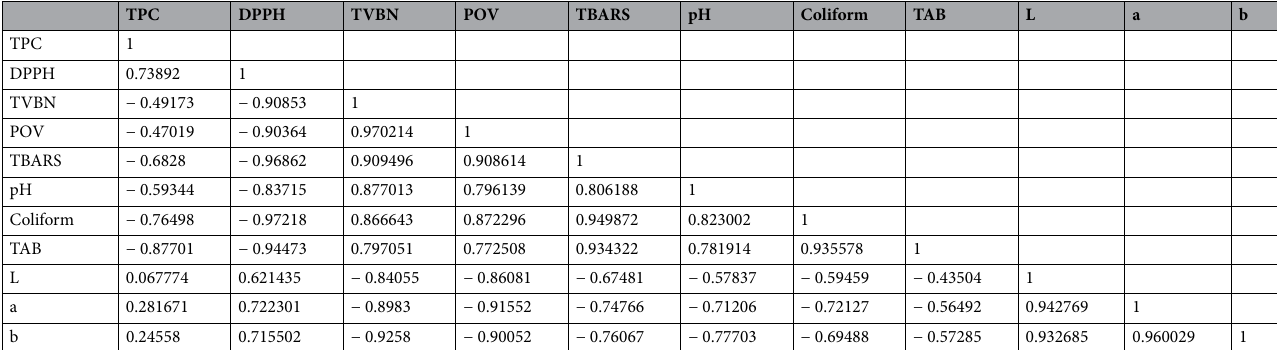
Table 10. Correlation study for CPH treated beef nuggets among different